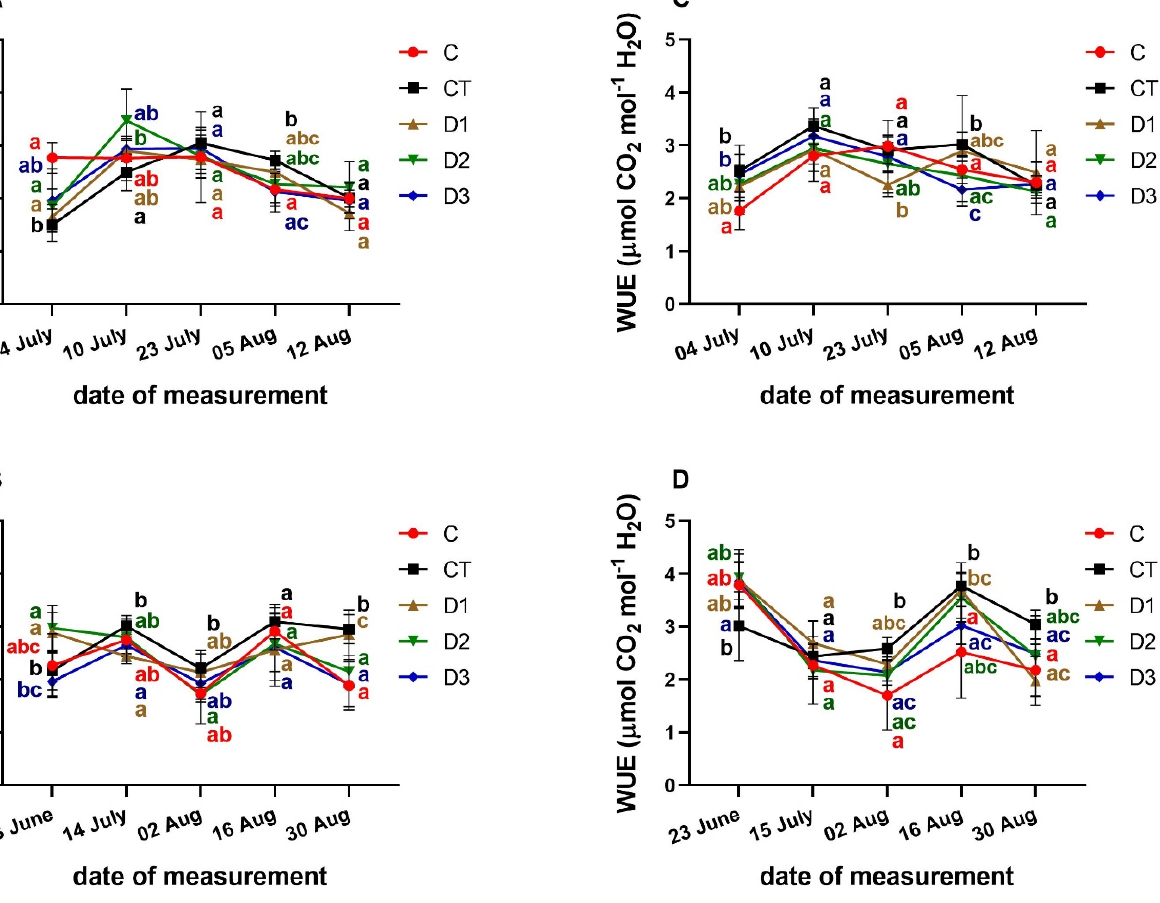
Figure 5. ( A – D ) Effects of treatments on extrinsic water-use efficiency ( WUE ) in Chardonnay ( A , B ) and Kékfrankos ( C , D ) varieties in 2013 ( A , C ) and 2014 ( B , D ). Extrinsic WUE was calculated in the case of each measurement: A (assimilation rate)/ E (transpiration rate). Each symbol represents the mean value ± standard deviation (SD). Significance groups of each measurement date are marked with letters ( p < 0.05). The color of the letters corresponds to the color of the treatments.